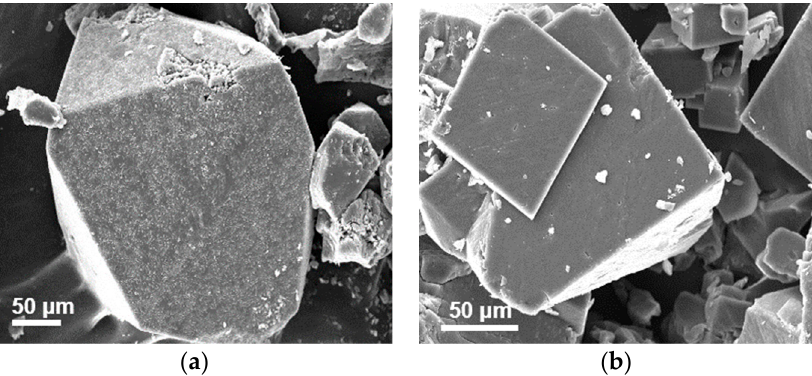
Figure 2. SEM image of ( a ) [NH 4 ][Mg(HCOO) 3 ] and ( b ) [(CH 3 ) 2 NH 2 ][Mg(HCOO) 3 ] crystals.